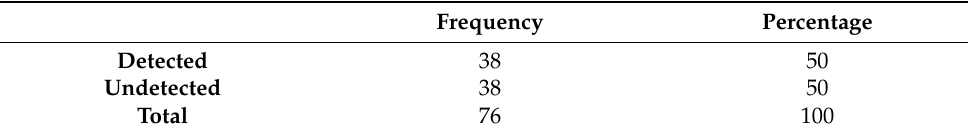
Table 4. Frequency and percentage of successfully detecting stair-climbing events by the distance sensors.